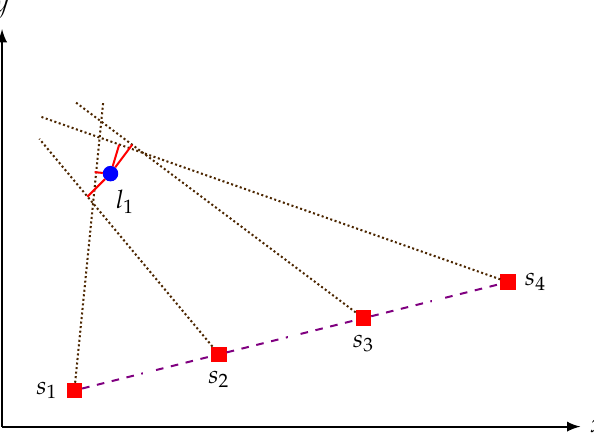
Figure 5. Illustration of the intuitions behind the suggested landmark position estimation algorithm. For each sensor position k one may identify from the raw distance measurements the angle between the sensor and the landmark, and thus the direction of the line from the sensor to the center of the landmark estimated while staying in position k (the dotted lines). Note that as while staying in position k the estimate of the center of the landmark is uncertain, these dotted lines do not aim perfectly at the actual center of the landmark, i.e., the blue dot labeled with l 1 . An intuitively meaningful strategy for estimating the unknown position of l 1 is then finding that point that minimizes the sum of its distances with the dotted lines from each position k . Given this intuition, the short solid red lines represent the distances between these directions and the center of the landmark.